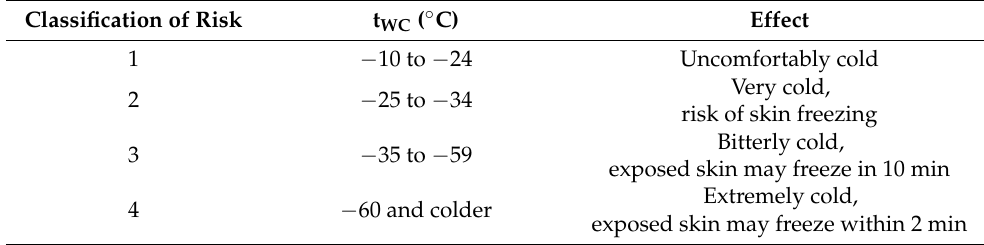
Table A2. Wind chill temperature (t WC ) and freezing time of exposed